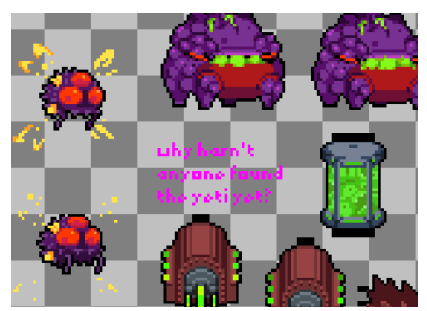
Fig. 5. Sprites in which some small parts are detached. Source: Nuclear Throne© game.